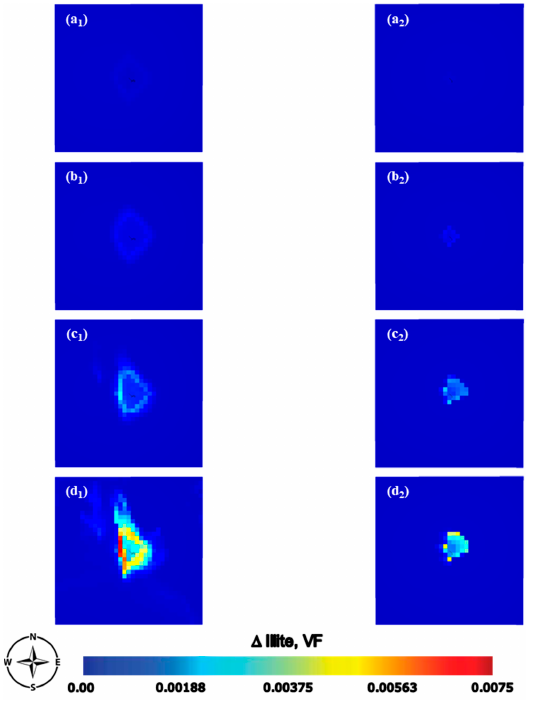
Figure A6. Plan view diagrams illustrating the simulated ∆ illite volume fraction evolution for the base case from the arkosic layer top view ( a 1 , b 1 , c 1 , d 1 ) and homogenous case from the Upper Mt. Simon top view ( a 2 , b 2 , c 2 , d 2 ) at ( a ) 30 years, ( b ) 100 years, ( c ) 1000 years, and ( d ) 10,000 years. Each figure’s size is 35 km × 35 km (x, y).